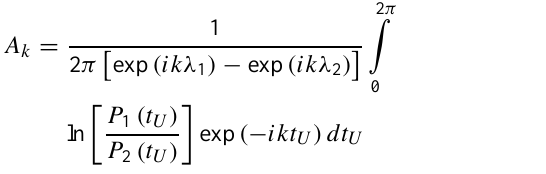
Fig. 1. A set of twelve model diurnal patterns, each corresponding to a month. Frame (a) depicts the Q ( t L ) data and frame (c) is the P ( t U ) variations. Intensities are measured in arbitrary units. Data for Lehta are shown by blue line and for Moshiri – by magenta line. Plot (b) depicts the intensity ratio P LEHTA / P MOSHIRI , and the lower green dotted curve presents the source